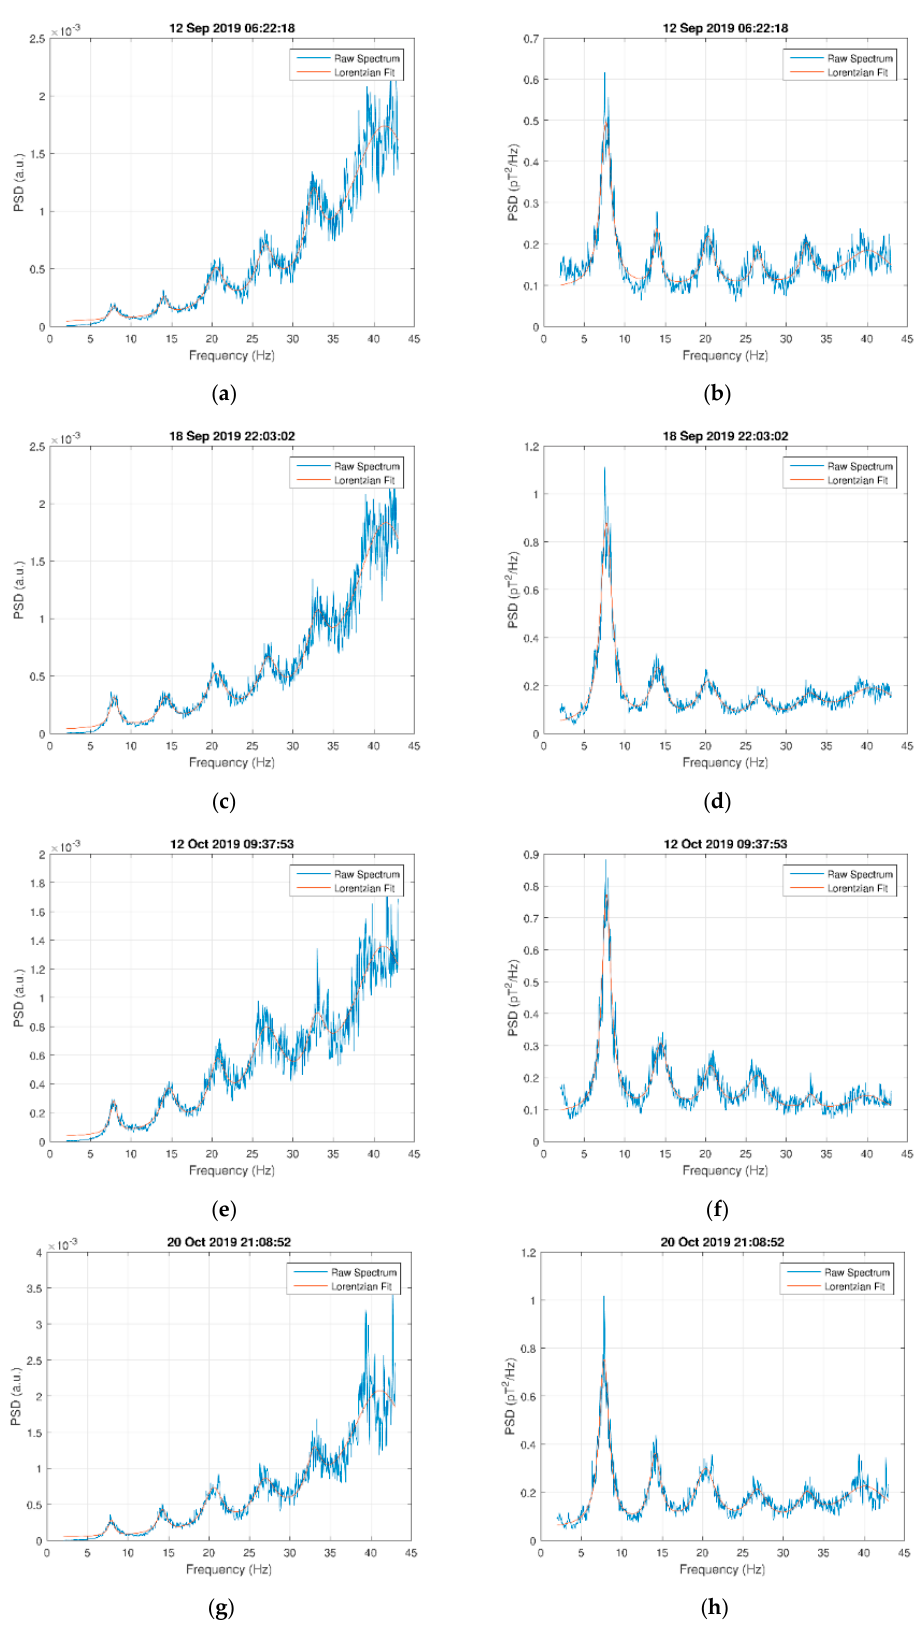
Figure 11. Comparison of measured spectra calculated with ( b , d , f , h ) and without ( a , c , e , g ) Schumann detector calibration.